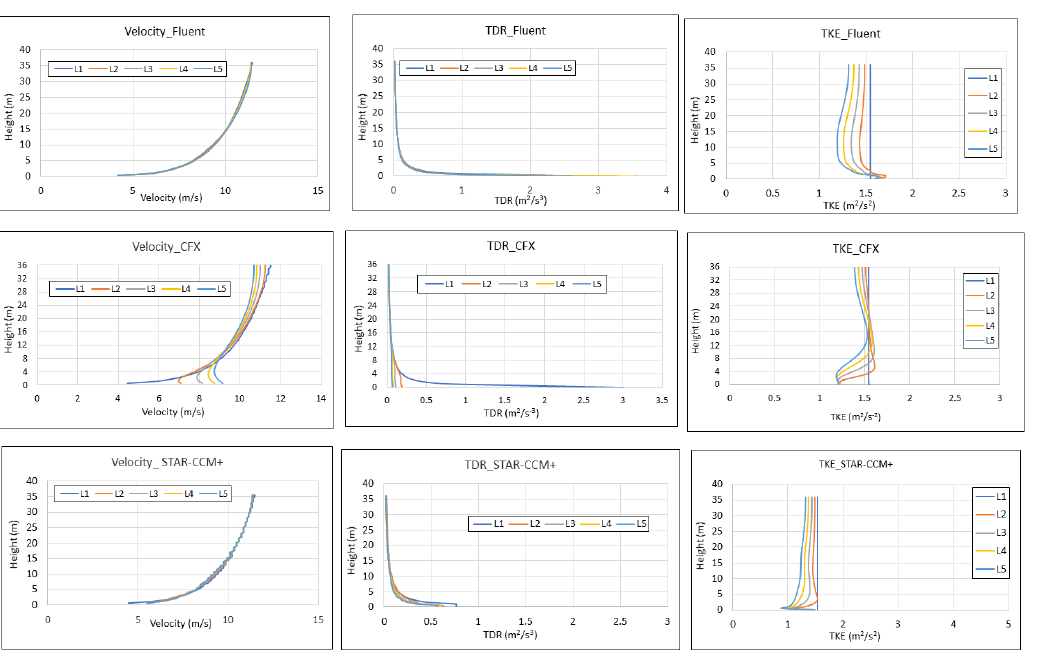
Figure 6. Case 1: Comparison of the vertical profiles of the streamwise velocity u , turbulent kinetic energy (TKE), and turbulent dissipation rate (TDR) with each